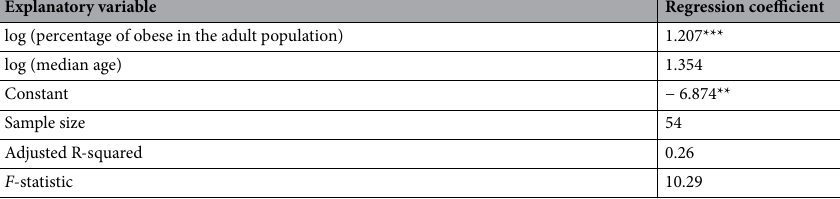
Table 3. COVID-19 Mortality and Proportion of Obese in Adult Population: Lower Middle-Income and Low- Income Countries. Dependent variable is log of COVID-19 Mortality. ***indicates that a regression coefficient is statistically significant at 1% level and **indicates that a regression coefficient is statistically significant at 5% level.